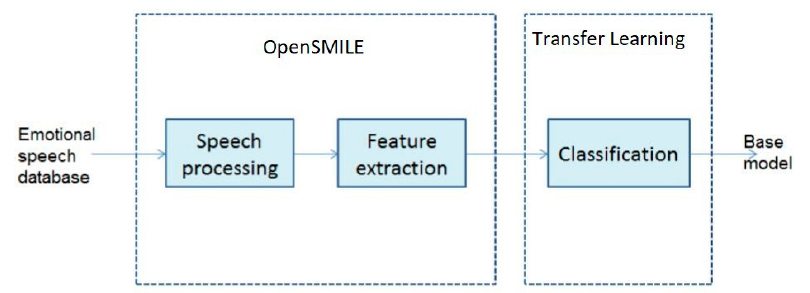
Figure 1. Proposed framework block diagram.